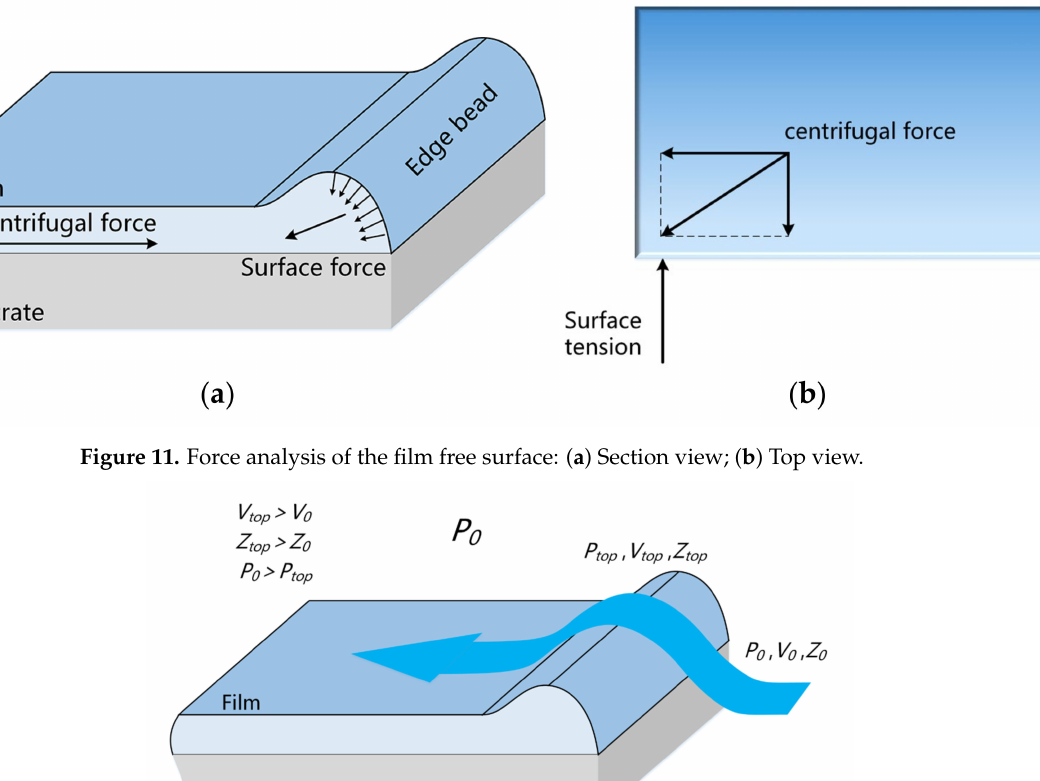
Figure 10. Velocity vector of the film at different spin-coating moments: ( a ) Internal velocity vector of liquid after spin- coating for 0.5 s; ( b ) Internal velocity vector of liquid after spin-coating for 6 s.